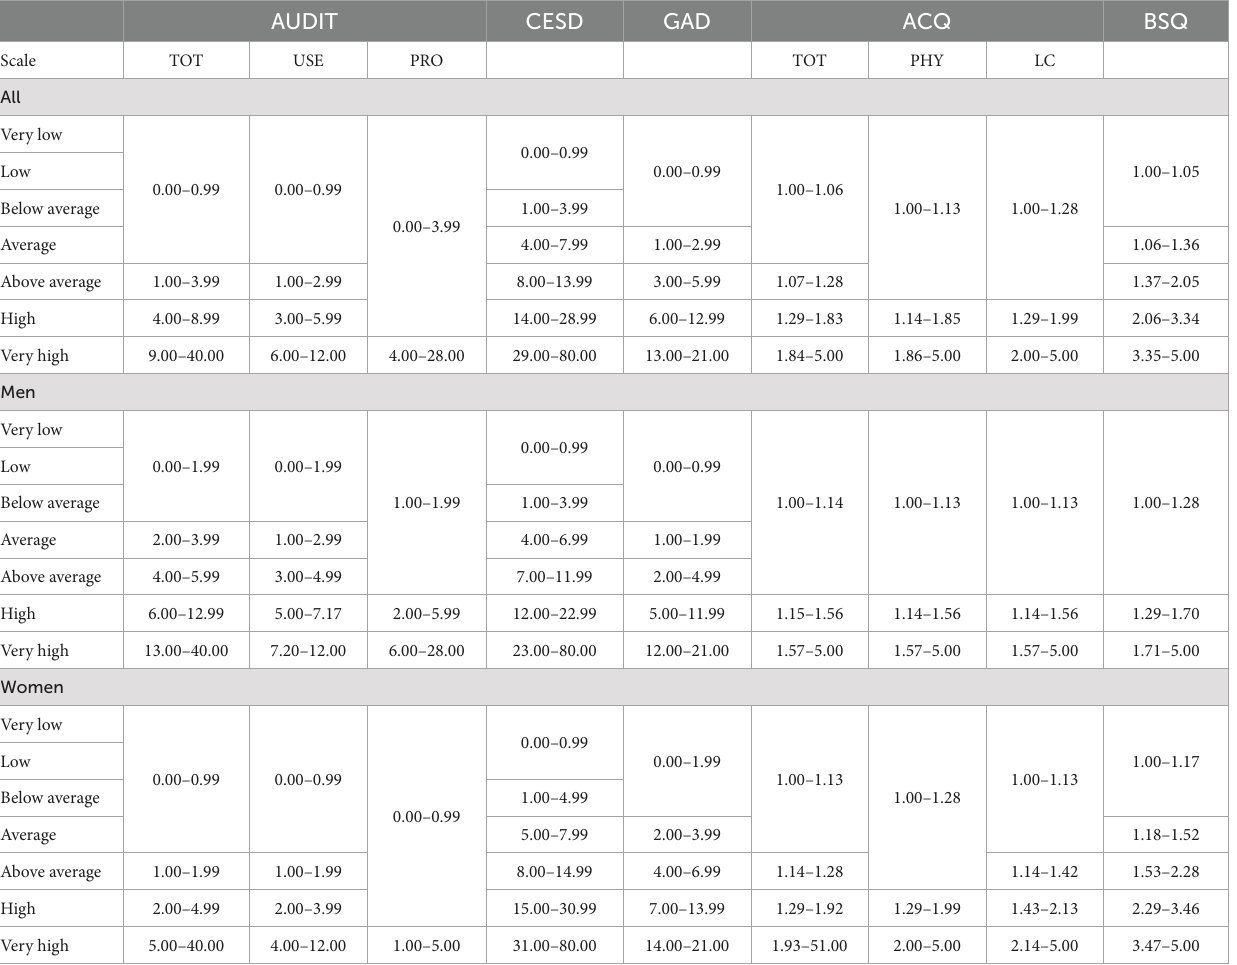
TABLE 1 Norms for all respondents, males, and females.